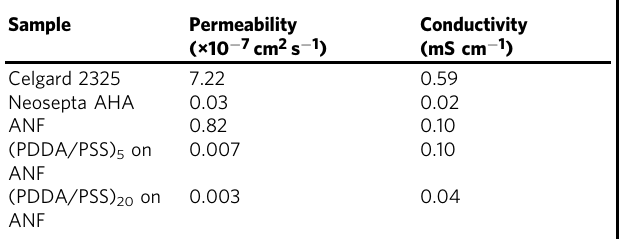
Table 1 Permeability and conductivity of Celgard 2325, Neosepta, aramid nano fi bre (ANF) separators and coated ANF